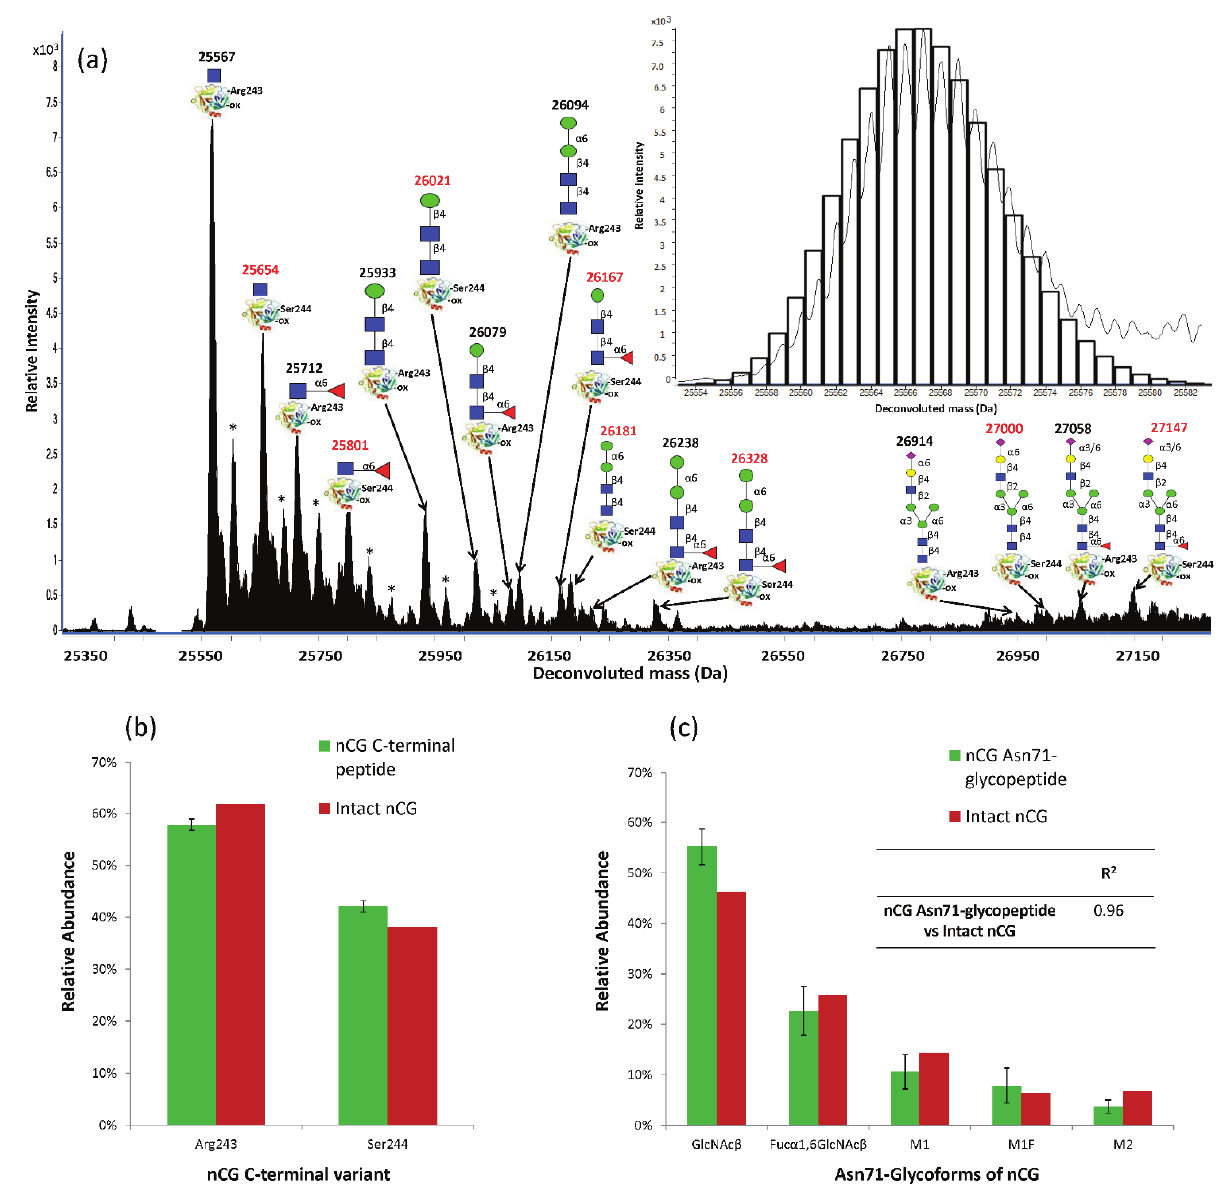
Figure 5. ( a ) QTOF LC-ESI-MS glycoprofiling of intact nCG at relative low fragmentor potential (200 V). The deconvoluted (average, apex) masses and structures of the individual nCG glycoforms are illustrated on the two C-terminal truncation variants of the protein (Arg243- and Ser244-C-terminal nCG variants in black and red, respectively). “-ox” denotes Met152 oxidation. * denotes adduct formation. Insert: Example of the accurate match of the theoretical (black bars) and the observed isotopic distribution of the Arg243-terminating and Asn71-GlcNAc(cid:2) and Met152-oxidation containing nCG; ( b ) The ratio of nCG Arg243- and Ser244-truncation variants was confirmed at the peptide level; ( c ) The similar nCG Asn71-glycopeptide and intact nCG glycoform profile, as evaluated by the high correlation coefficient ( R 2 ), confirmed the relative distribution of the Asn71-glycans. The trace Asn71-glycoforms were not included in this quantitative comparison. Data points are plotted as mean ± SD, n =